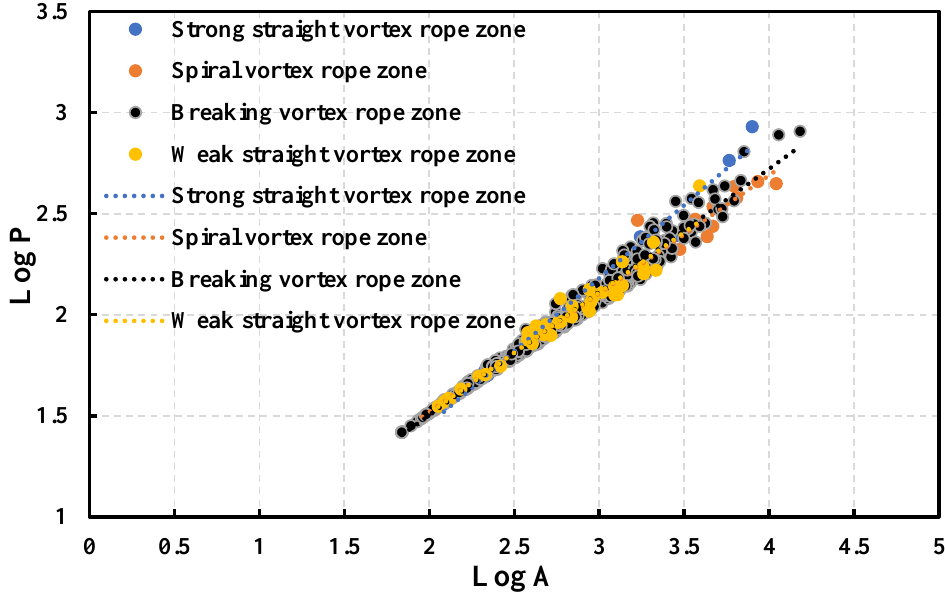
Figure 13. Fractal dimension relation of vortex circumferences and areas in four zones of draft tube.